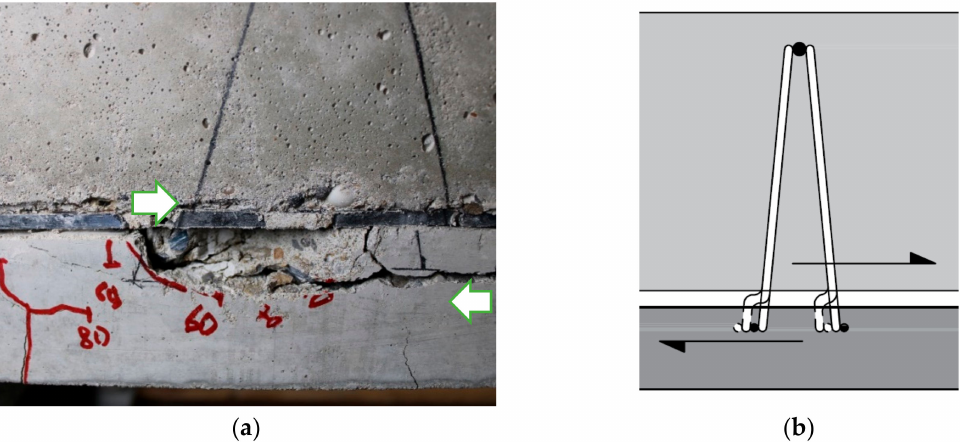
Figure 15. Deformation of the lattice girder: ( a ) picture after the test C05 (unloaded); ( b ) schematic forces and de- formed